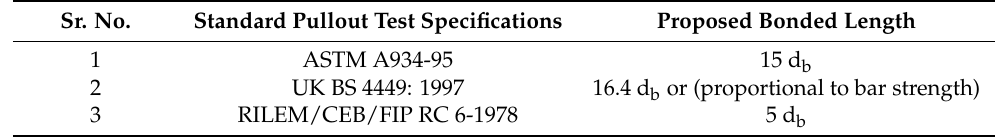
Table 1. Proposed bond lengths based on various research. Sr. No.